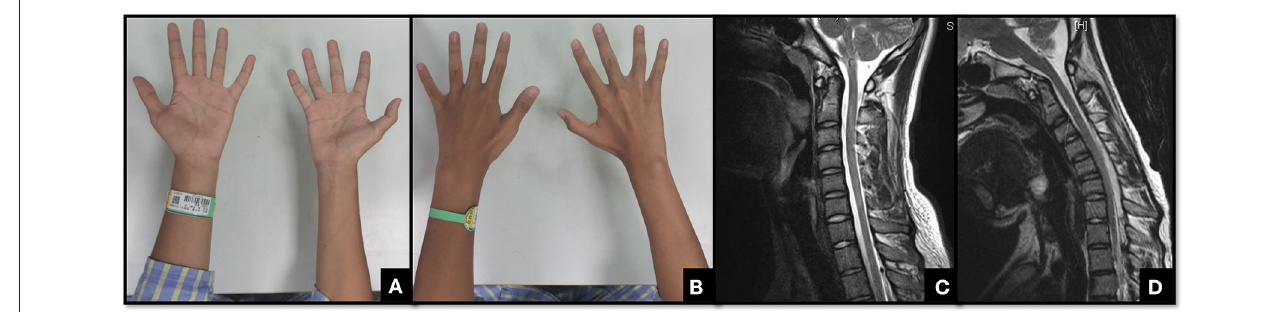
FIGURE 1 | A 16-year-old male with weakness of the right hand for ∼ 1 year. (A,B) show the obvious atrophy of the hypothenar and the first dorsal interosseous muscle in his right hand. (C) shows the spinal cord is slightly thin and without compression from C5 to C7. (D) shows there is noticeable cyst–wall separation behind the spinal cord in the cervical flexion position. This patient was characterized by atrophy and weakness of the unilateral upper limb, without sensory dysfunction and pyramidal signs. So, he was classified as having Type I Hirayama disease. In addition, his clinical symptoms became worse in the recent 6 months and should be determined as Type Ib.